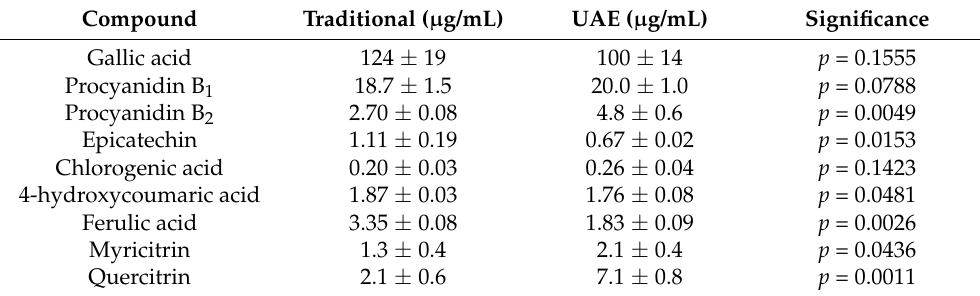
Table 2. Content of the identified phenolic compounds in traditional and UAE carob syrup.